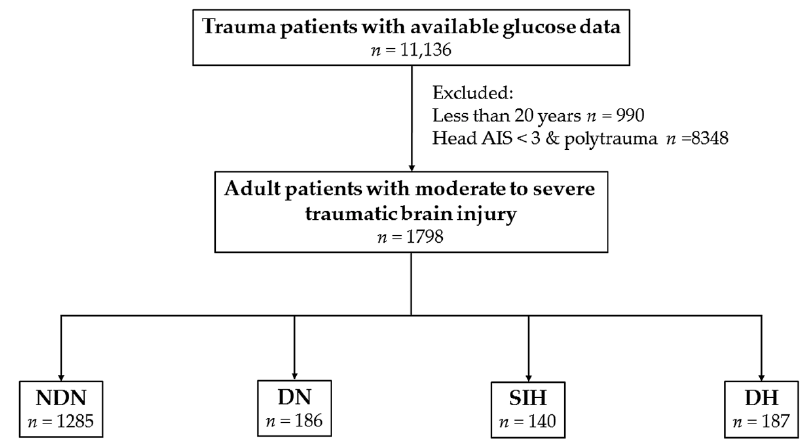
Figure 1. Flowchart of the allocation of patients with isolated moderate and severe traumatic brain injuries into four exclusive groups of non ‐ diabetic normoglycemia (NDN), diabetic normoglycemia (DN), stress ‐ induced hyperglycemia (SIH), and diabetic hyperglycemia (DH).